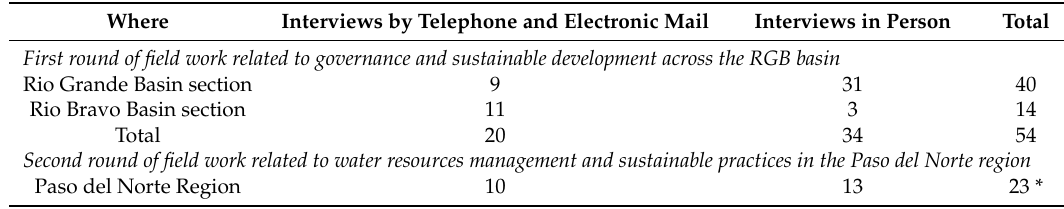
Table A1. Distribution of the interviews and the way they were